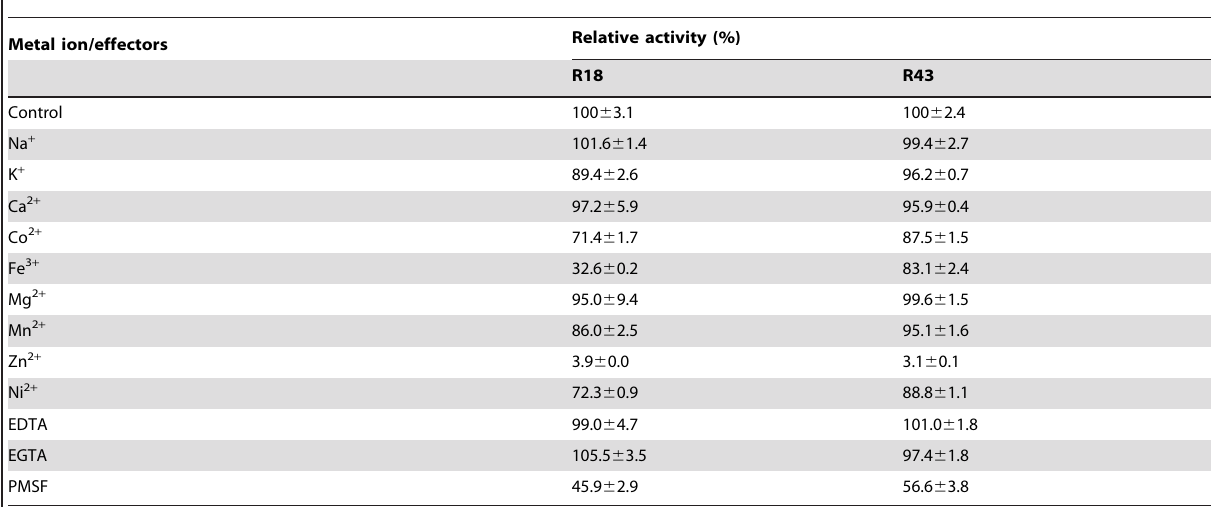
Figure 3. Characterization of the FAE activity of R18 and R43. Effect of temperature (A) and pH (B) on the FAE activity of R18 and thermostability (C). Effect of temperature (D) and pH (E) on the FAE activity of R43 and thermostability (F). Averages from three independent experiments are shown. Error bars represent standard deviations. doi:10.1371/journal.pone.0104584.g003 Table 1. Effect of metal ion/effectors in R18 and